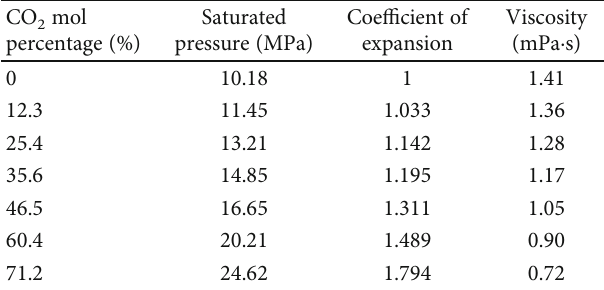
Table 7: The CO -crude oil interactions at formation temperature. 2